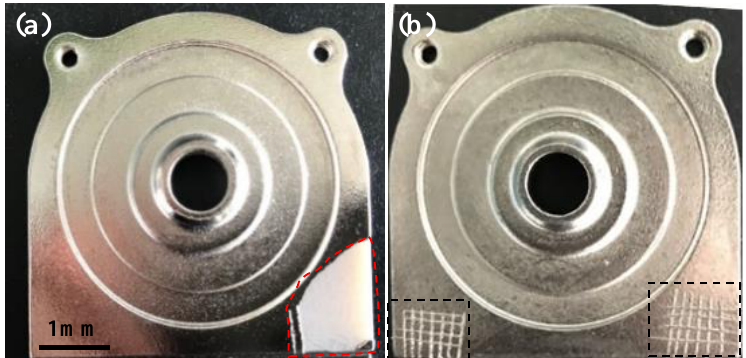
Figure 5. Digital images of Ni/Cu/Ni multilayer deposits on PEI substrates without ( a ) and with ( b ) sandblasting process after cross-cut test by 3M tape.